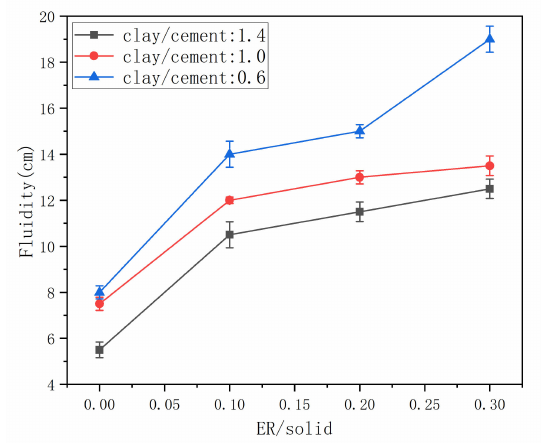
Figure 4. The fluidity of grout.